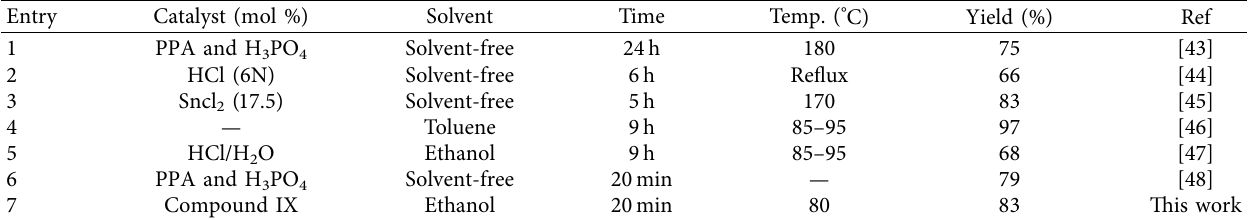
(compound IX). Table 1: Comparisons of trinuclear cationic copper (II) complex (compound IX) with the applied catalysts in the synthesis of benzimidazole